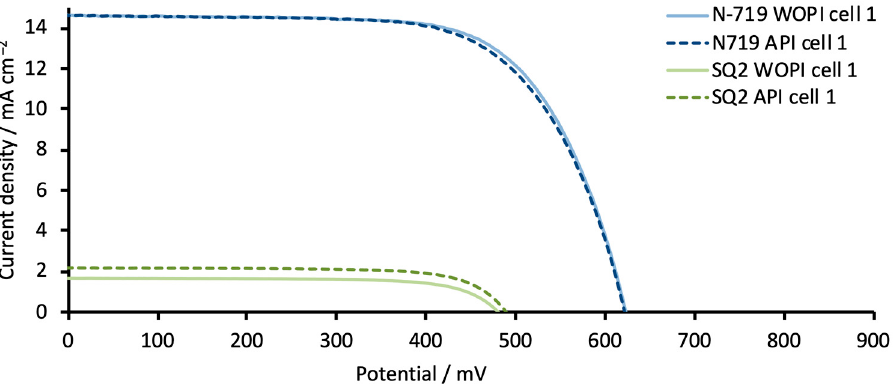
Figure 5. J – V curves for dyes N719 (blue) and SQ2 (green) measured WOPI and after a preirradiation time (API) of 15 min. The data for duplicate DSCs and the J – V parameters are presented in Figure S1 and Table S1 (Supplementary Materials).